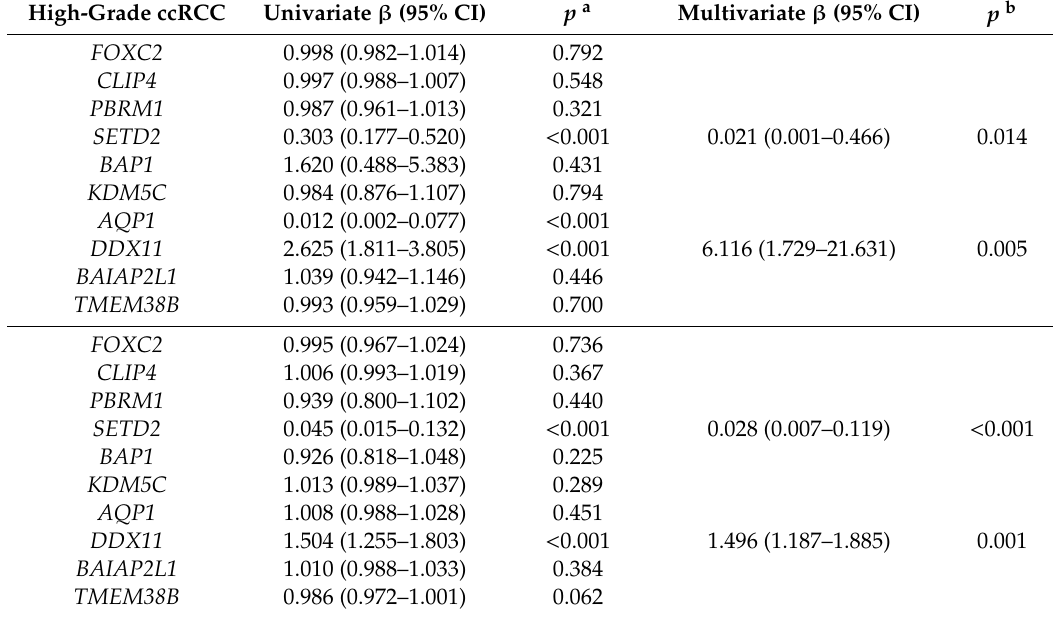
Table 2. Univariate and multivariate logistic regression analyses of the mRNA levels of target genes associated with high-grade clear cell renal cell